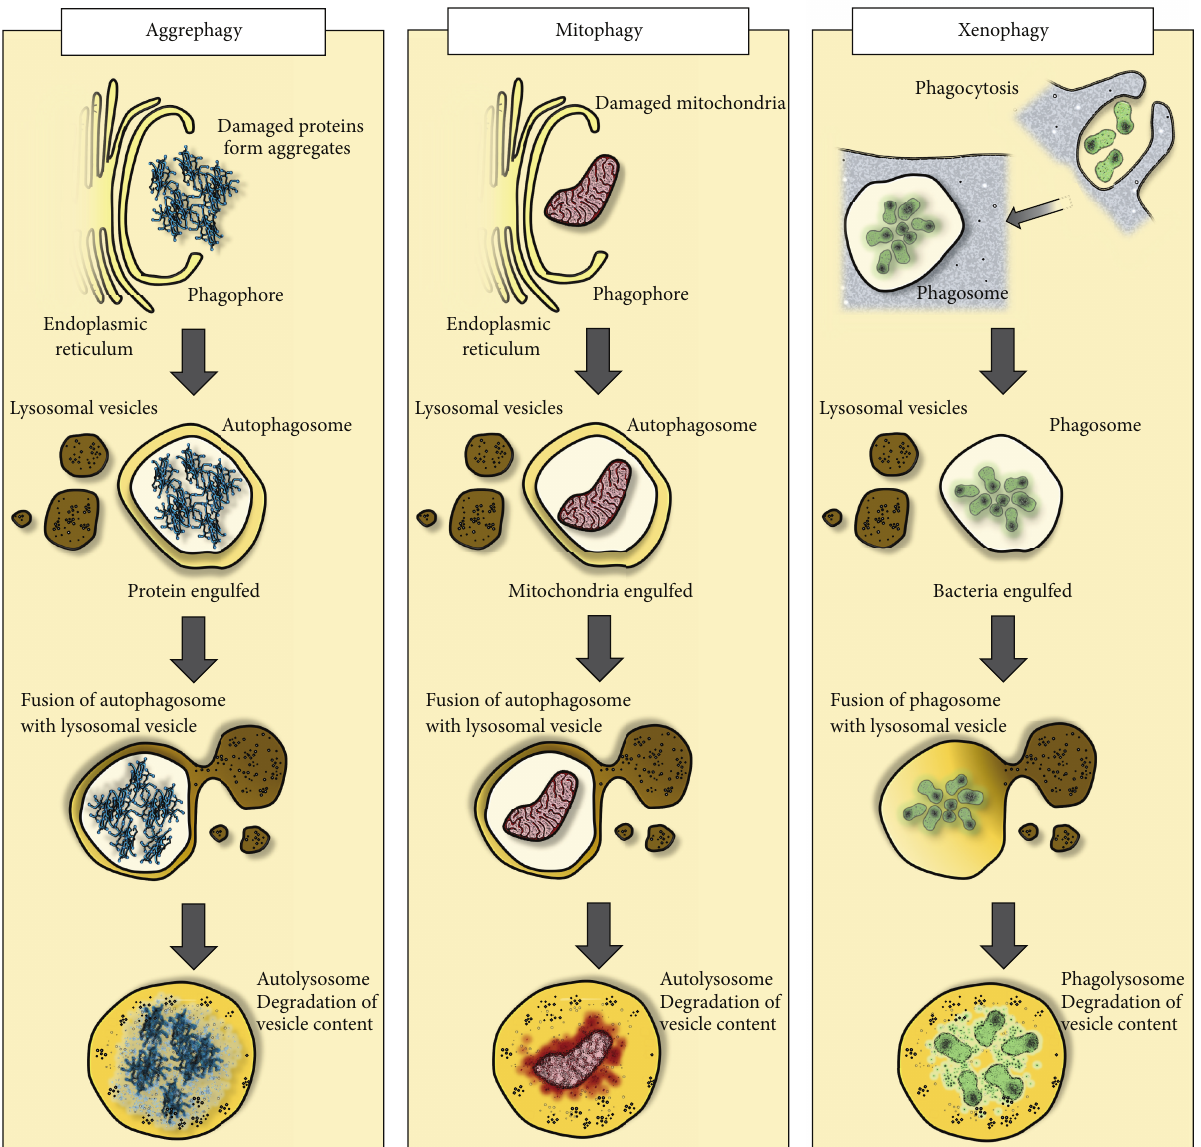
Figure 2: Autophagy plays a critical role in pathogen clearance and host survival. The fibril response as well as oxidative stress resulting from tissue ischemia or immune activation may damage proteins which in turn form toxic aggregates which are cleared by autophagy (“aggrephagy”). Similarly, damaged and dysfunctional mitochondria are targeted for cellular digestion (mitophagy), thus optimising energy generation while diminishing ROS production. Autophagy is also involved in the clearance of intracellular pathogens (xenophagy) in both immune and nonimmune cells. Not demonstrated, autophagic processes are also involved in epitope expression and may provide an alternative form of cell death in viral-infected cells. Also, autophagy may modulate the inflammatory tone by possessing membrane receptors and singling platforms such as the